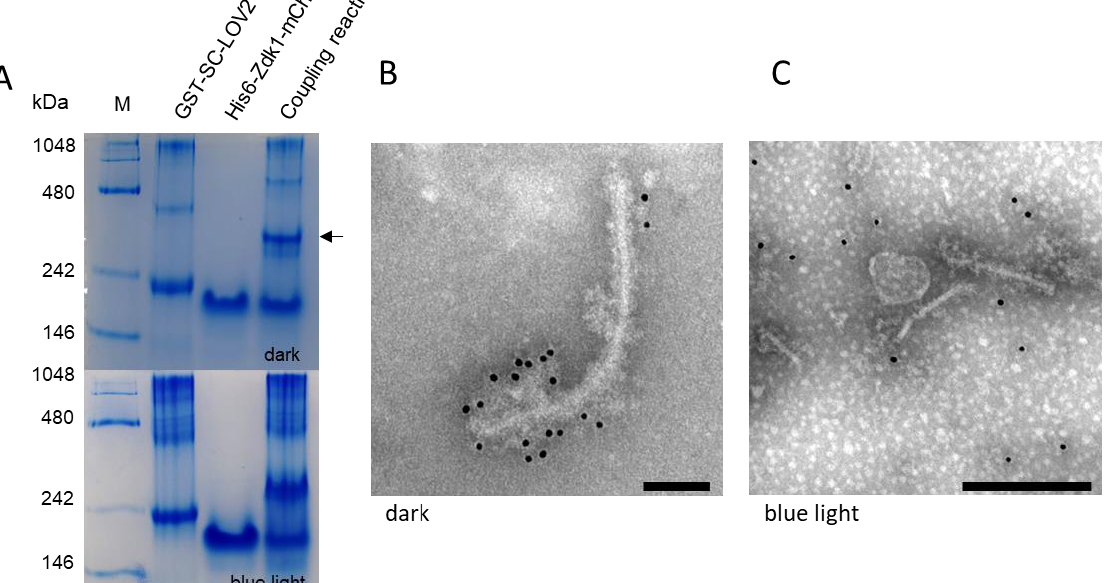
Figure 3. Analysis of the modified LOVTRAP system. ( A ) Interaction between the purified LOV2 and Zdk1 proteins analyzed by discontinuous native PAGE. In the dark, the bands representing the individual proteins GST-SC-LOV2 and His 6 -Zdk1-mCherry are joined by a higher-molecular- weight band (indicated by an arrow) representing the complex, which is not present under blue light. M = NativeMark standards. ( B ) Transmission electron micrograph showing the LOVTRAP system attached to PVX particles in the dark. Purified PVX-ST/GST-SC-LOV2 particles were mixed with His 6 -Zdk1-mCherry and incubated for 30 min in the dark. Particles were attached to the grids and His 6 -Zdk1-mCherry was detected with an anti-His 6 /GAM-12 nm gold conjugate. Immunogold decoration was observed only for the mixture of PVX-ST/GST-SC-LOV2 + His 6 -Zdk1-mCherry in the dark. ( C ) Transmission electron micrograph showing purified PVX-ST/GST-SC-LOV2 particles mixed with His 6 -Zdk1-mCherry. The mixture was incubated for 30 min in the dark. Particles were attached to the grids under blue light (455 nm) and His 6 -Zdk1-mCherry was detected with an anti-His 6 /GAM-12 nm gold conjugate. No immunogold decoration was observed on the particles. Scale bar = 100 nm ( B ), 250 nm ( C ). Controls are shown in Figure